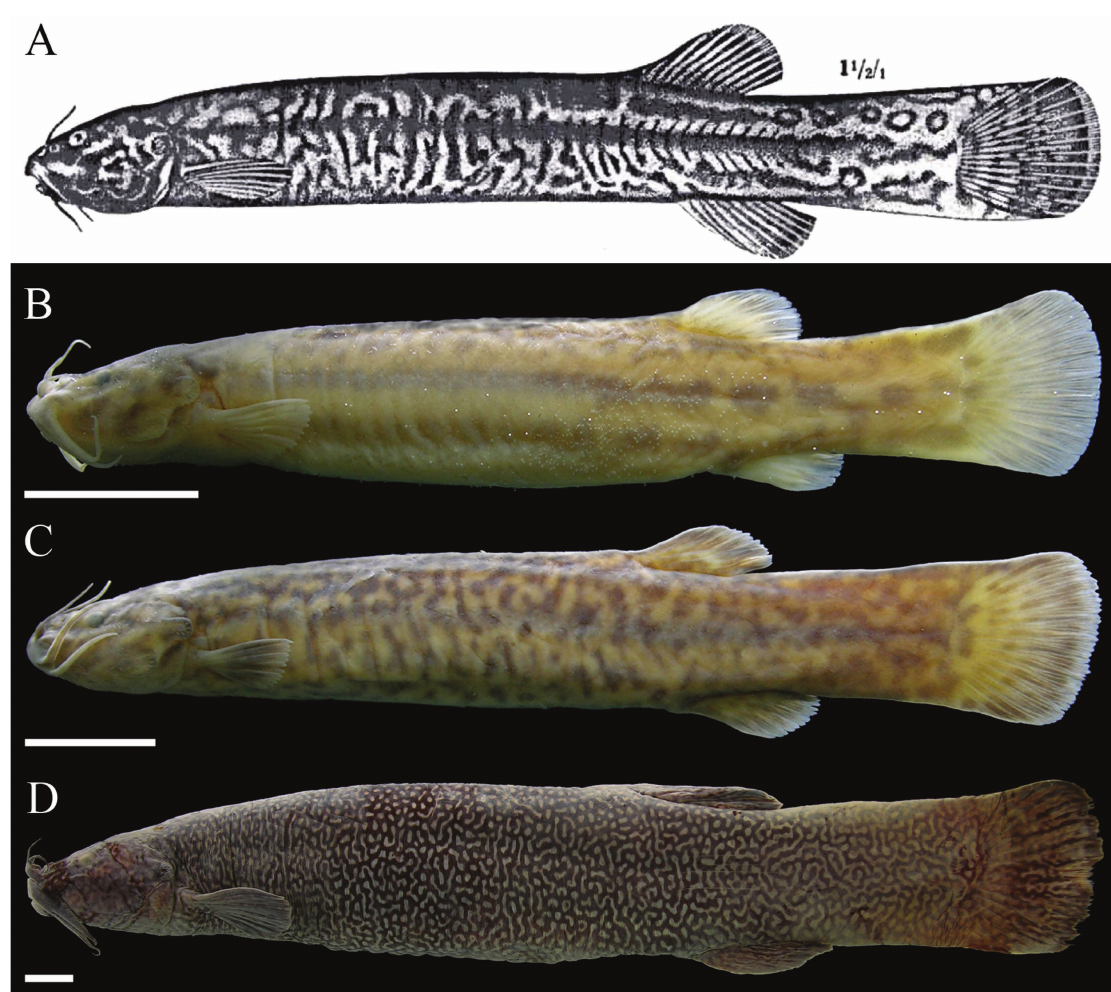
Fig. 1. A. Trichomycterus venulosus , syntype of Pygidium venulosum , 87 mm SL, illustration from Steindachner (1915b); B. Eremophilus mutisii , MPUJ 2528, 54.0 mm SL, Colombia, Cundinamarca, Municipio Guatavita, embalse de Tominé, Vereda Chaleche, Club Náutico Refugio de Tominé, 4º59’10.7”N 73º49’09”W, 2622 m asl, río Magdalena basin; C. E. mutisii , MPUJ 2528, 72.1 mm SL; D. E. mutisii , MBUCV-V-32796, 221.9 mm SL, Colombia, Nariño, Laguna de La Cocha, río Guamuéz drainage, tributary of río Putumayo, Amazon River basin. Scale bars 1